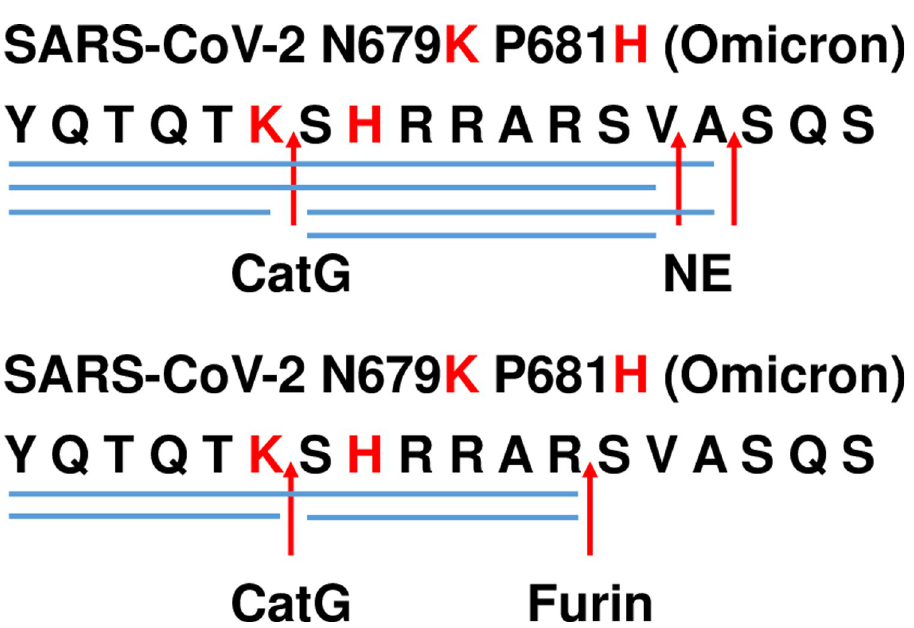
Fig 4. Proteolytic cleavage sites by the combined action of CatG, furin, and NE. 200 μ g/ml SARS-CoV-2 N679K P681R (Omicron) peptide was incubated with equal amounts of CatG and NE (4 μ g/ml, upper panel) or 4 μ g/ml of CatG, furin, and NE for 2h at 37˚C. The peptide turnover was determined by HPLC and mass spectrometry (n = 2).